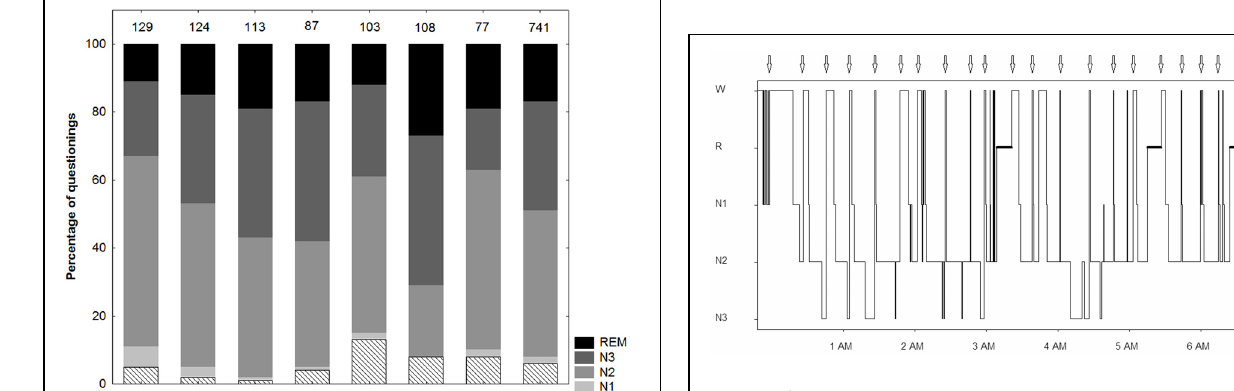
FIGURE 2 | Hypnogram of a study night with 22 questionings (indicated by arrows at the top of the graph). W, wakefulness; R, REM